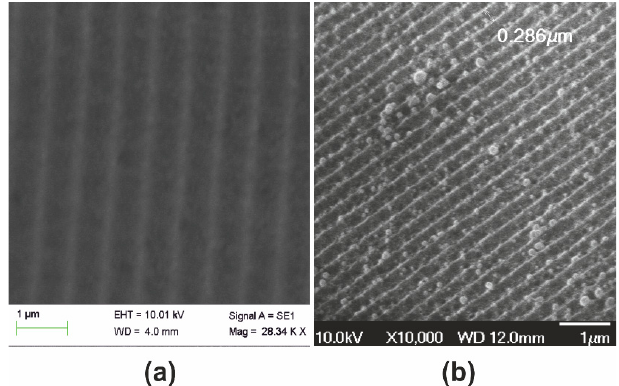
Figure 3. Nanostructure formation by systolic processing of aerogel grating at 900 °C: ( a ) original aerogel surface relief pattern of period Λ aero ~750 nm (as in Figure 2); and ( b ) resulting surface relief pattern having grating period Λ aero-I ~280 nm, downsized by a factor SF ~2.8× with respect to the original. The small droplets observed on the surface are produced by the resolidified Au used for the SEM analysis of the aerogel sample shown in ( a ).